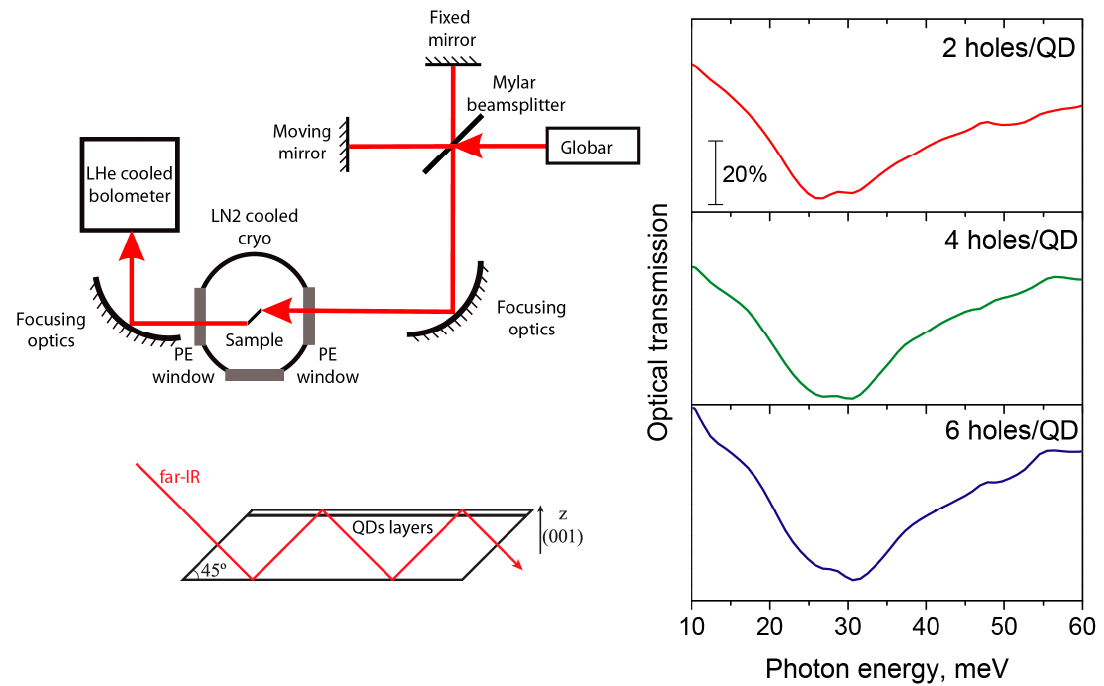
Figure 2. Experiment schematics and the measured far-IR transmission spectra of the Ge/Si quantum dot structures with different doping levels at 80 K. The labels at the curves indicate the nominal doping level.